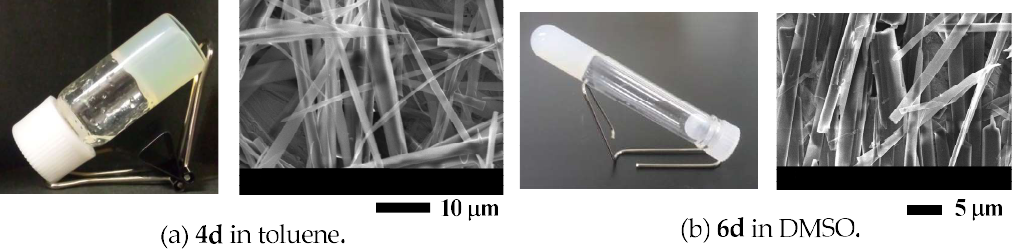
Figure 1. Optical and SEM images of gels. ( a ) 4d in toluene; ( b ) 6d in DMSO.